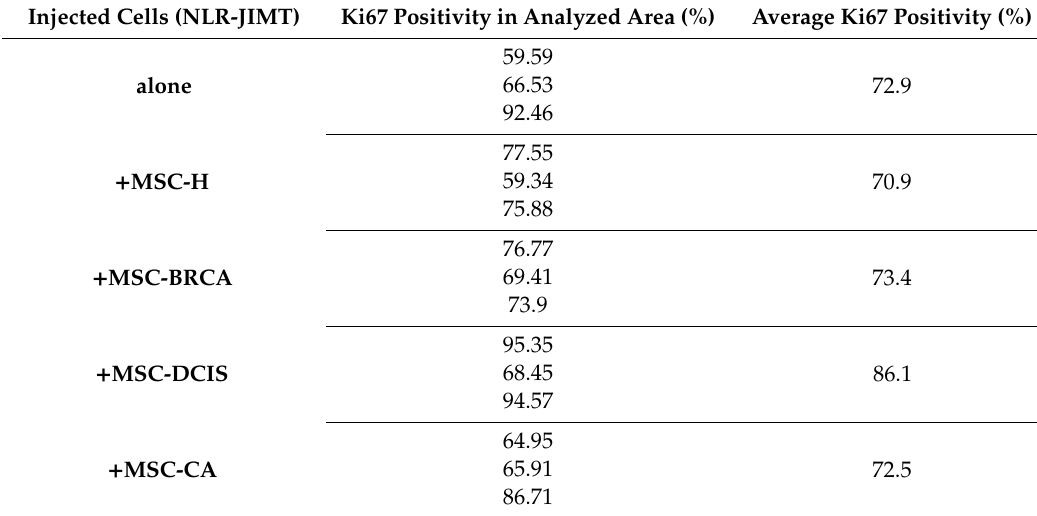
Table 1. Ki67 score in tumor xenografts. Ki67 expression analysis in several areas of tissue section revealed its uneven distribution throughout the xenograft. When a higher number of zones was investigated, the Ki67 staining quantification showed similar expression in all